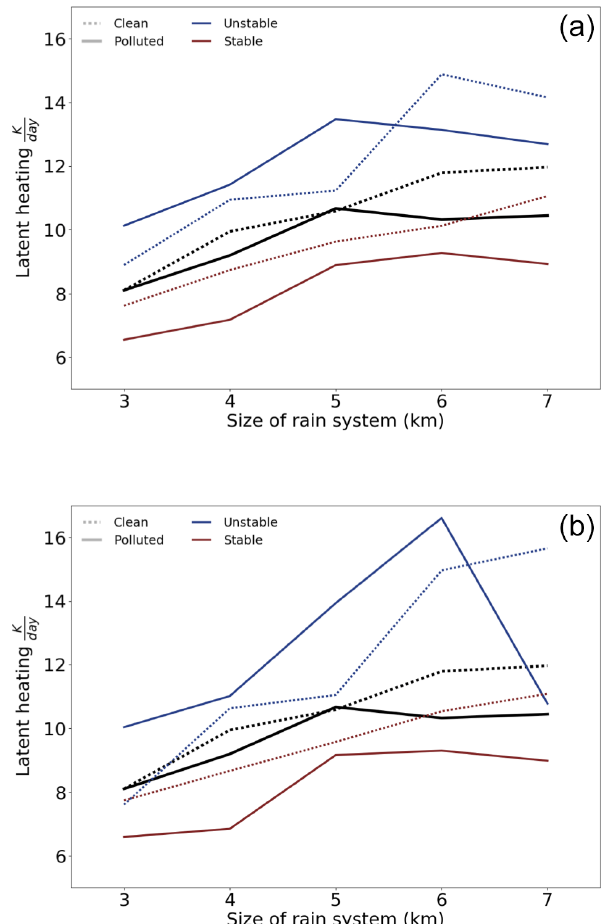
Figure 2. The mean amount of latent heating released due to pre- cipitation formation rate in the geometrical center of the rain sys- tem as a function of rain system size for all (a) and dry (b) warm clouds with an extent of 15km. Black is for all stabilities, blue is for unstable environments, and red is for stable environments; dashed represents pristine and solid represents polluted surroundings.